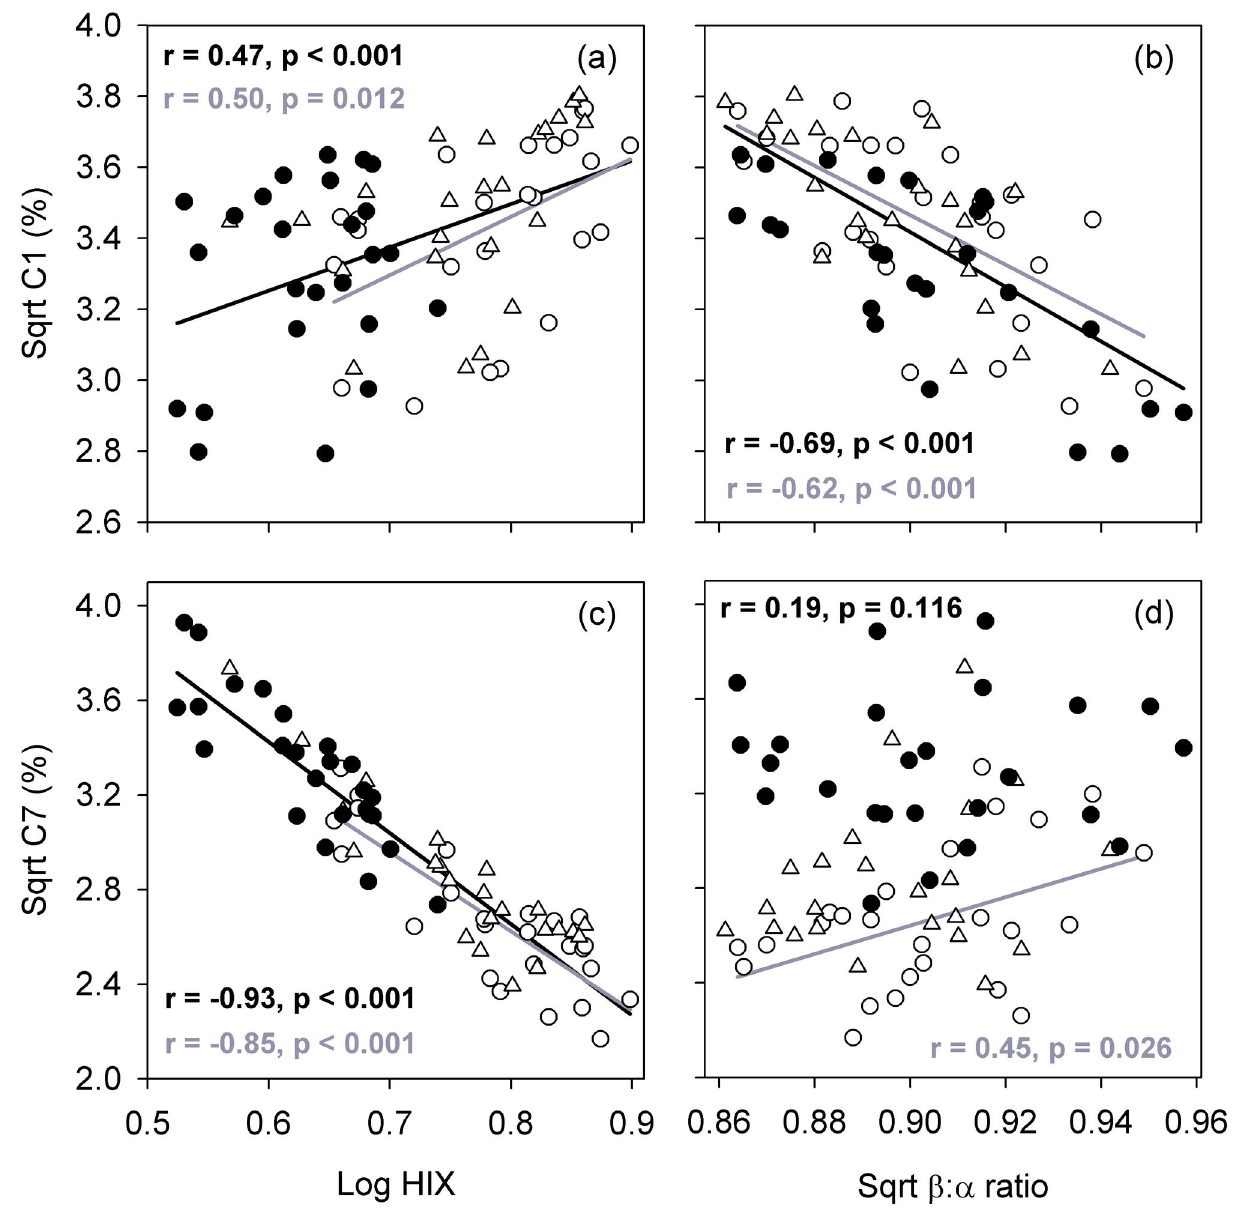
Figure 4. Photo-induced changes in DOM chemistry. Correlations between the EEM-PARAFAC model C1 (a,b) and C7 (c,d), and the humification index (HIX; a,c) and β:α ratio (b,d) for 25 urban ponds in August (open circles=initial (T0, prior to photo- irradiation), closed circles=light treatment (T24L), triangles=dark treatment (T24D). Correlations are presented for the overall data set (black lines) and T0 (gray